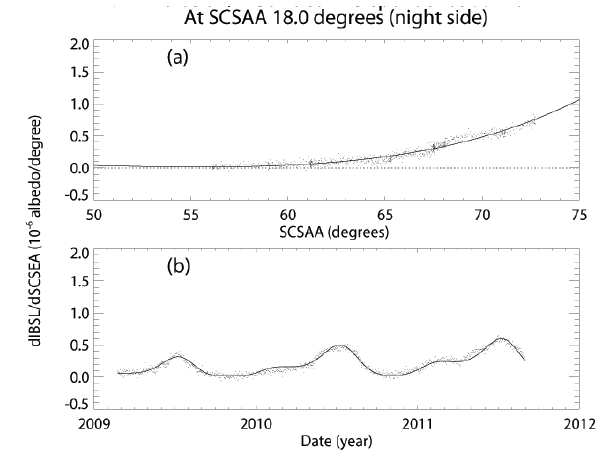
Fig. 11. Dashed curves in the top panel are for 12 channels of fit- ted G (SCSAA) functions, which can be approximated within 0.7% of IBSL by a product of a wavelength independent factor for the SCSAA dependence and the scale factors in the bottom panel, g 0 (SCSAA) × C(λ) .